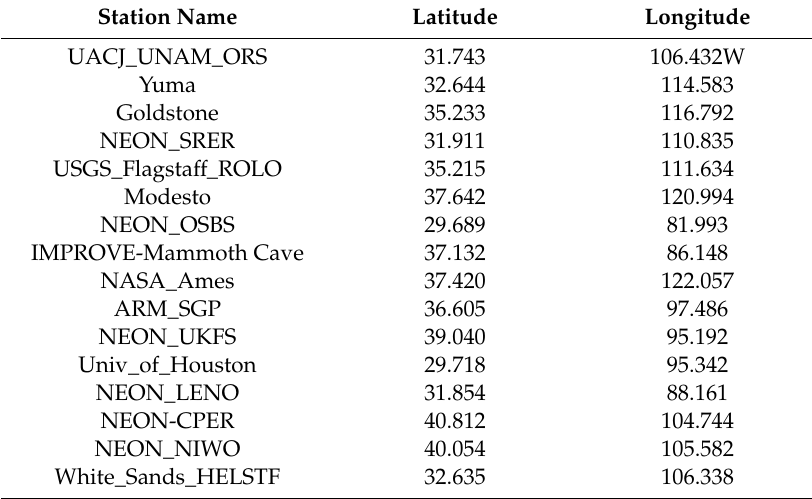
Table 3. Details of the Aerosol Robotic Network (AERONET) ground-based stations used for validation of retrieved PWV from FY-3D MERSI-2 over North